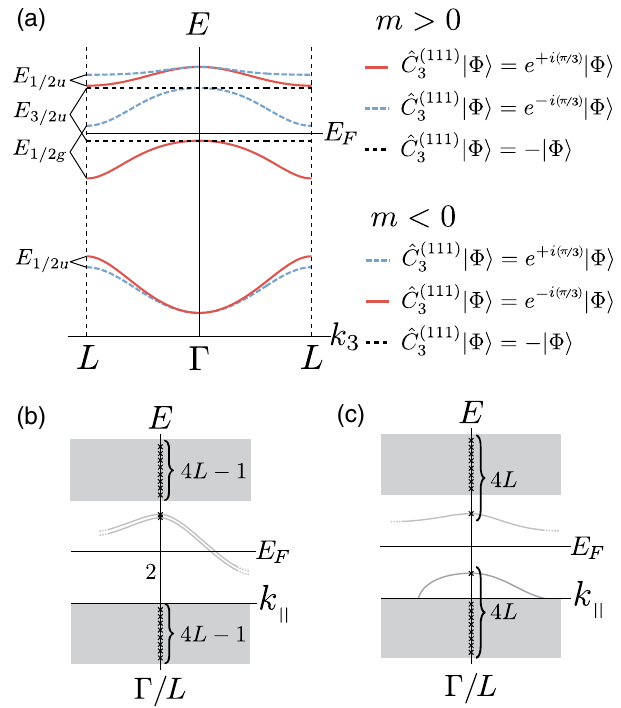
FIG. 8. (a) Classification of the eigenstates at the projected L point. For illustrative purposes, the eigenstates are shown under the translational invariance along the (111) axis or the Γ L line. These eigenstates are invariant under the threefold rotation and, thus, labeled by the eigenvalues of the operator the eigenstates are e (cid:2) i ð π = 3 Þ and − 1 . For the all-out domain ( m > 0 ), the solid red (dotted blue) curves represent the eigen- states with the eigenvalue e þ i ð π = 3 Þ ( e − i ð π = 3 Þ ). After applying the time-reversal operation, namely, in the all-in domain ( m < 0 ), these eigenstates are switched as the eigenvalue e − i ð π = 3 Þ ( e þ i ð π = 3 Þ ) corresponds to the solid red (dashed blue) curves. (b) Schematic energy spectrum of a bulk with a single domain wall along momentum k ∥ that is perpendicular to k 3 , with the protected twofold degeneracy of the domain-wall states. These doubly degenerated domain-wall dispersions can be characterized by clockwise and counterclockwise chiral spin textures. The domain-wall states by themselves do not possess the inversion symmetry around the projected Γ and/or L points. (c) Schematic possible energy spectrum along k ∥ without the degeneracy of the domain-wall